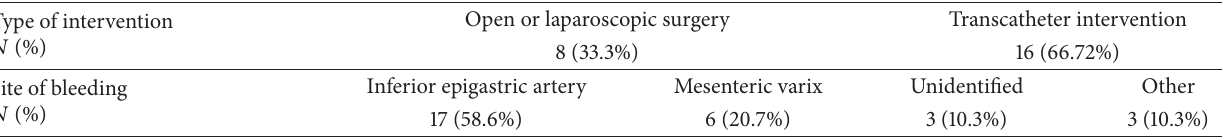
Table 3: Identified site of bleeding and type of intervention in subjects in hemorrhagic